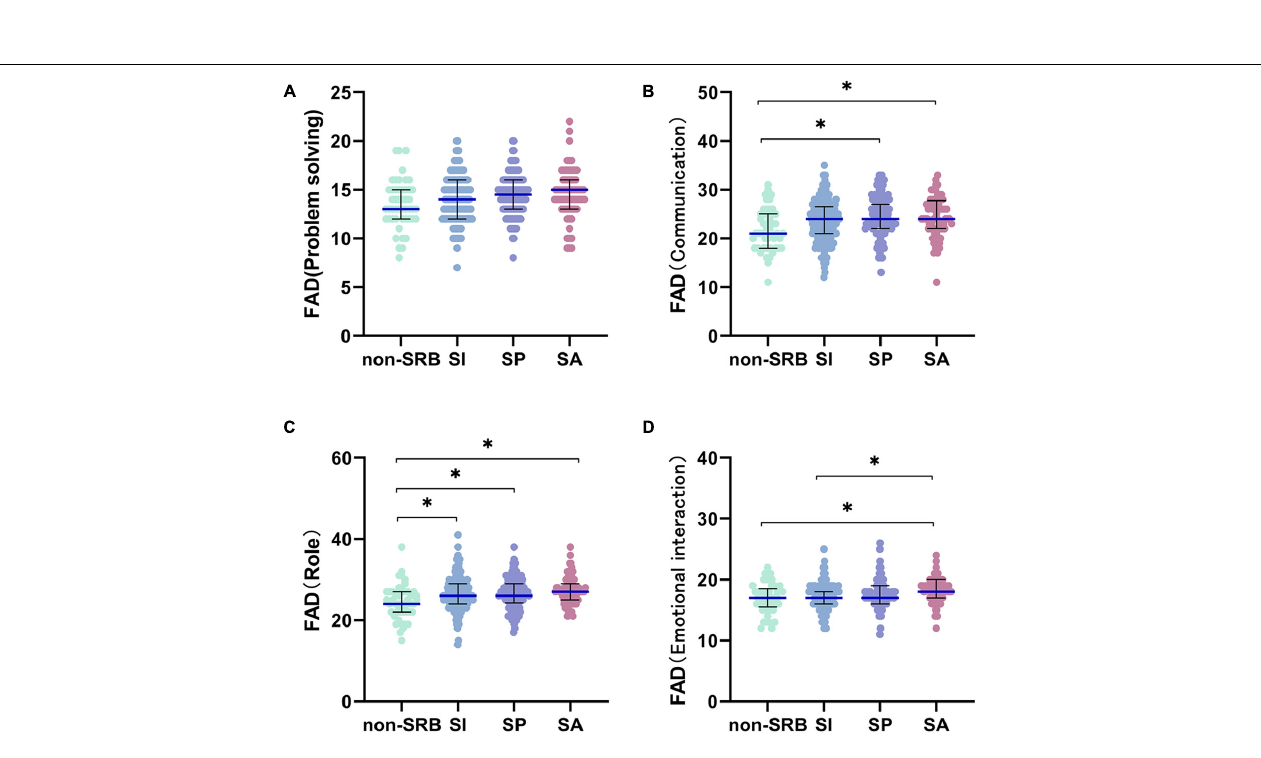
FIGURE 5 | Pairwise comparison of FAD. (A) Problem solving of family function. (B) Communication of family function. (C) Role of family function. (D) Emotional interaction of family function. ∗ P < 0.05. Non-SRB, group without suicide-related behavior; SI, group with suicidal ideation; SP, group with suicidal plan; SA, group with suicidal